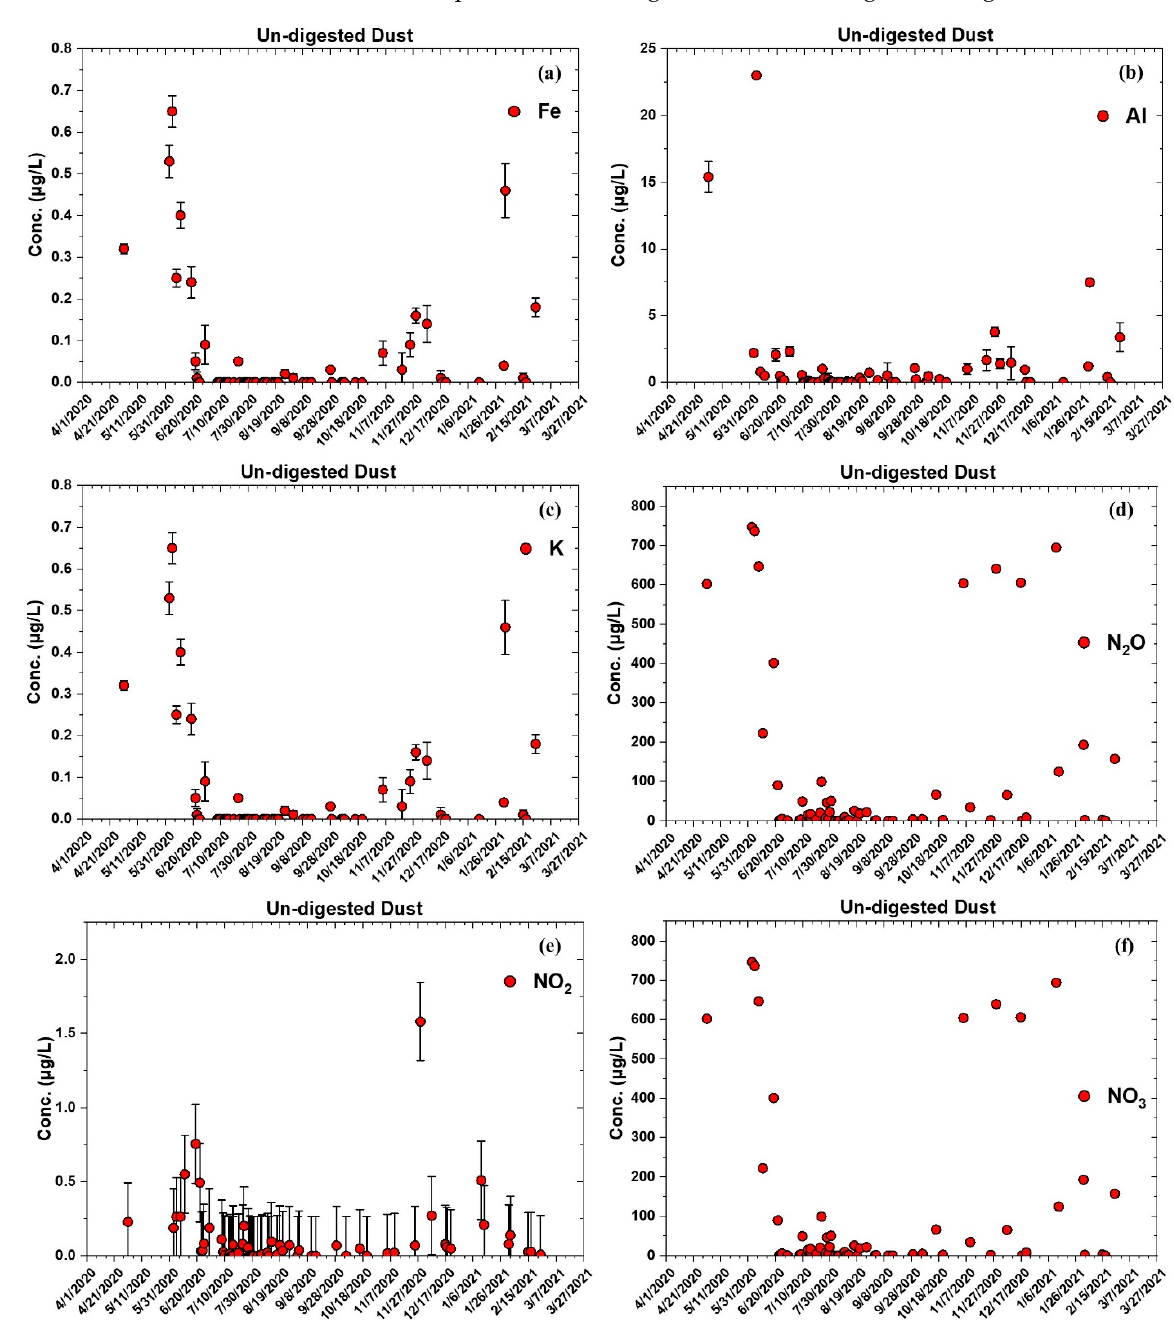
Figure 5. Concentrations of undigested aerosols (soluble fractions) including Fe, Al, and K) and nutrients (N 2 O, NO 2 , and NO 3 ) in rainfall at the ETI collection site. Note that where the error bars are difficult to see, they are small compared to the concentration.